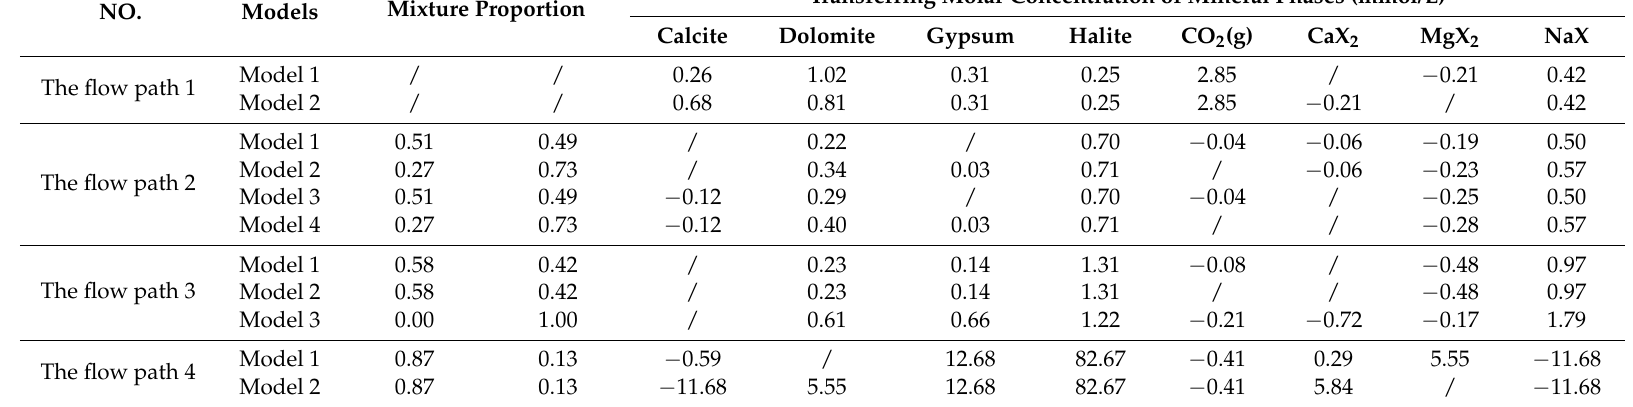
Table 2. Simulating results for inverse